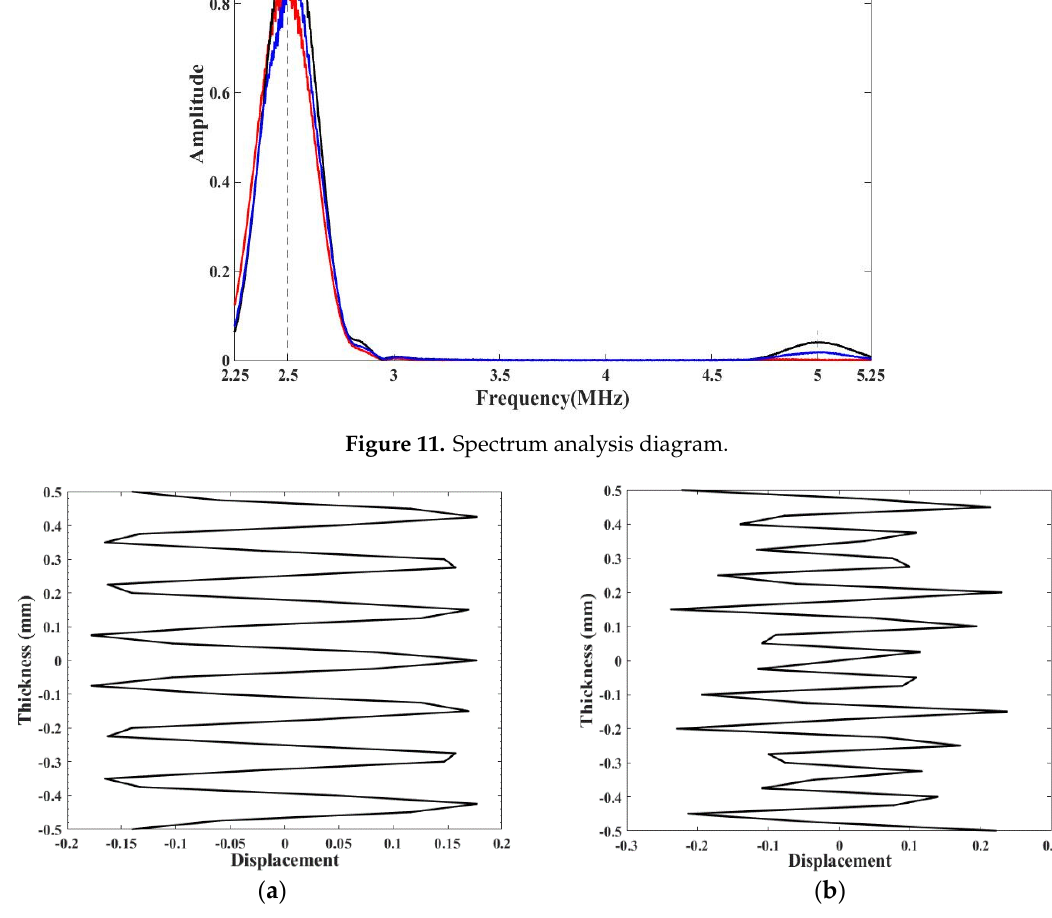
Figure 11. Spectrum analysis diagram.